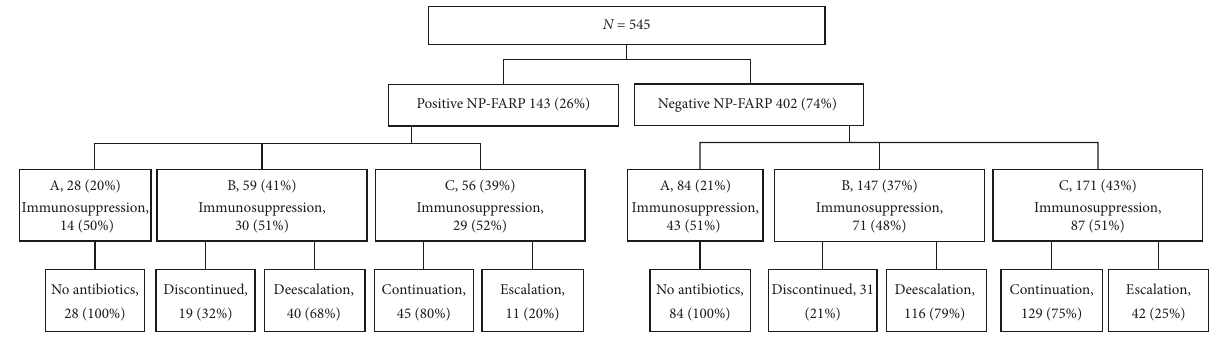
Figure 1: Flow diagram depicting positive and negative NP-FARP cohorts with subsequent antibiotic decisions. NP-FARP, nasopharyngeal FilmArray respiratory